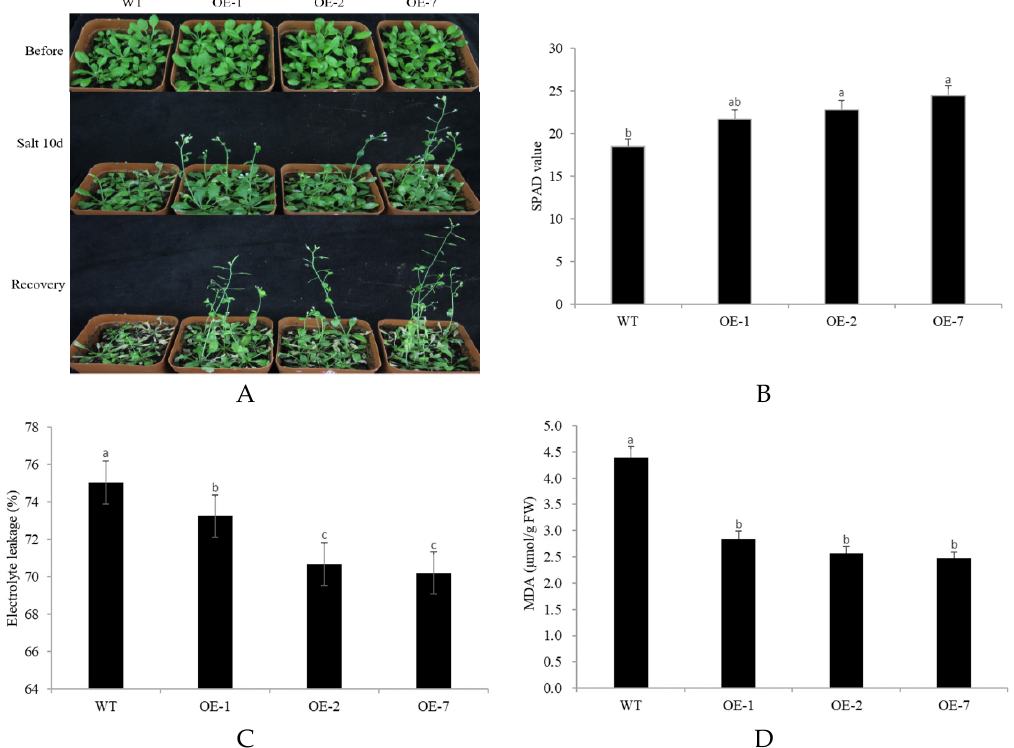
Figure 7. Overexpression of CpNAC68 confers enhanced tolerance to salt stress in transgenic Arabidopsis. ( A ) Performance of OE lines and WT plants after salt stress for 10 days, followed by recovery at normal conditions for 4 days. Images were taken at the indicated time points. ( B ) SPAD value of OE lines and WT plants under salt treatment. ( C ) Electrolyte leakage of OE lines and WT plants under salt treatment. ( D ) MDA content of OE lines and WT plants under salt treatment. Values represent the averages of three independent repeated trials. Data represent the mean ± SE. Bars correspond to the standard error. The significance test was performed by Duncan’s multiple range test, which is indicated by different letters.